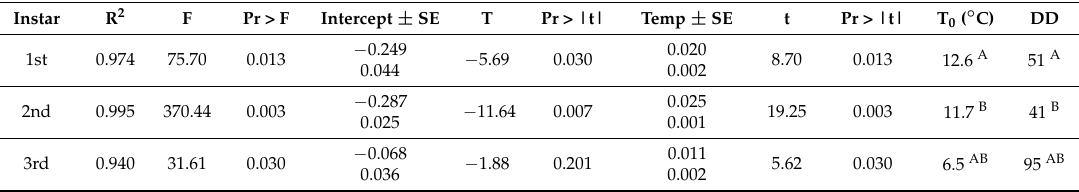
Figure 6. Temperature dependent mortality of Agrotis segetum pupae at eight different constant temperatures was modelled as proportion dead pupae = a + bT +cT 2 : Proportion dead pupae = 3.3658 − 0.2904T + 0.0062T 2 ; R 2 = 0.817, F = 11.28, p = 0.0140. The dashed lines above and below represent the upper and lower 95% confidence bands. Table 1. Linear models of development rates for 1st, 2nd and 3rd instar larvae of Agrotis segetum at temperatures of 15, 17, 20 and 25 ◦ C, showing a clearly significant effect of temperature and significant intercepts for 1st and 2nd instars, but not for 3rd instar. The second to last column shows the calculated base temperature for each of the three instars and the last column shows the calculated heat requirement in Degree